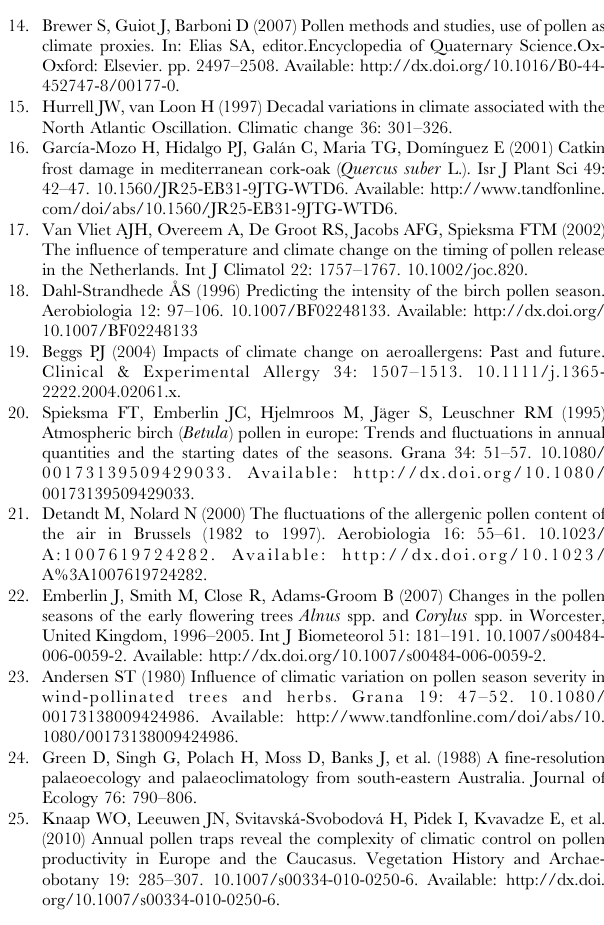
Figure S1 Total annual pollen accumulation rates of all recorded taxa in the pollen traps from LUMC, Leiden, and climate variables from De Bilt, The Netherlands from 1969 to 2012. Figure S2 Autocorrelation of LUMC pollen accumula- tion rates for 0 to 20 years lags. Curved lines represent 95% significance level. File S1 This file contains Table S1–Table S3. Table S1. Pollen count data for LUMC pollen traps. Table S2. Pollen count data for Elkerliek pollen traps. Table S3. The peat core from